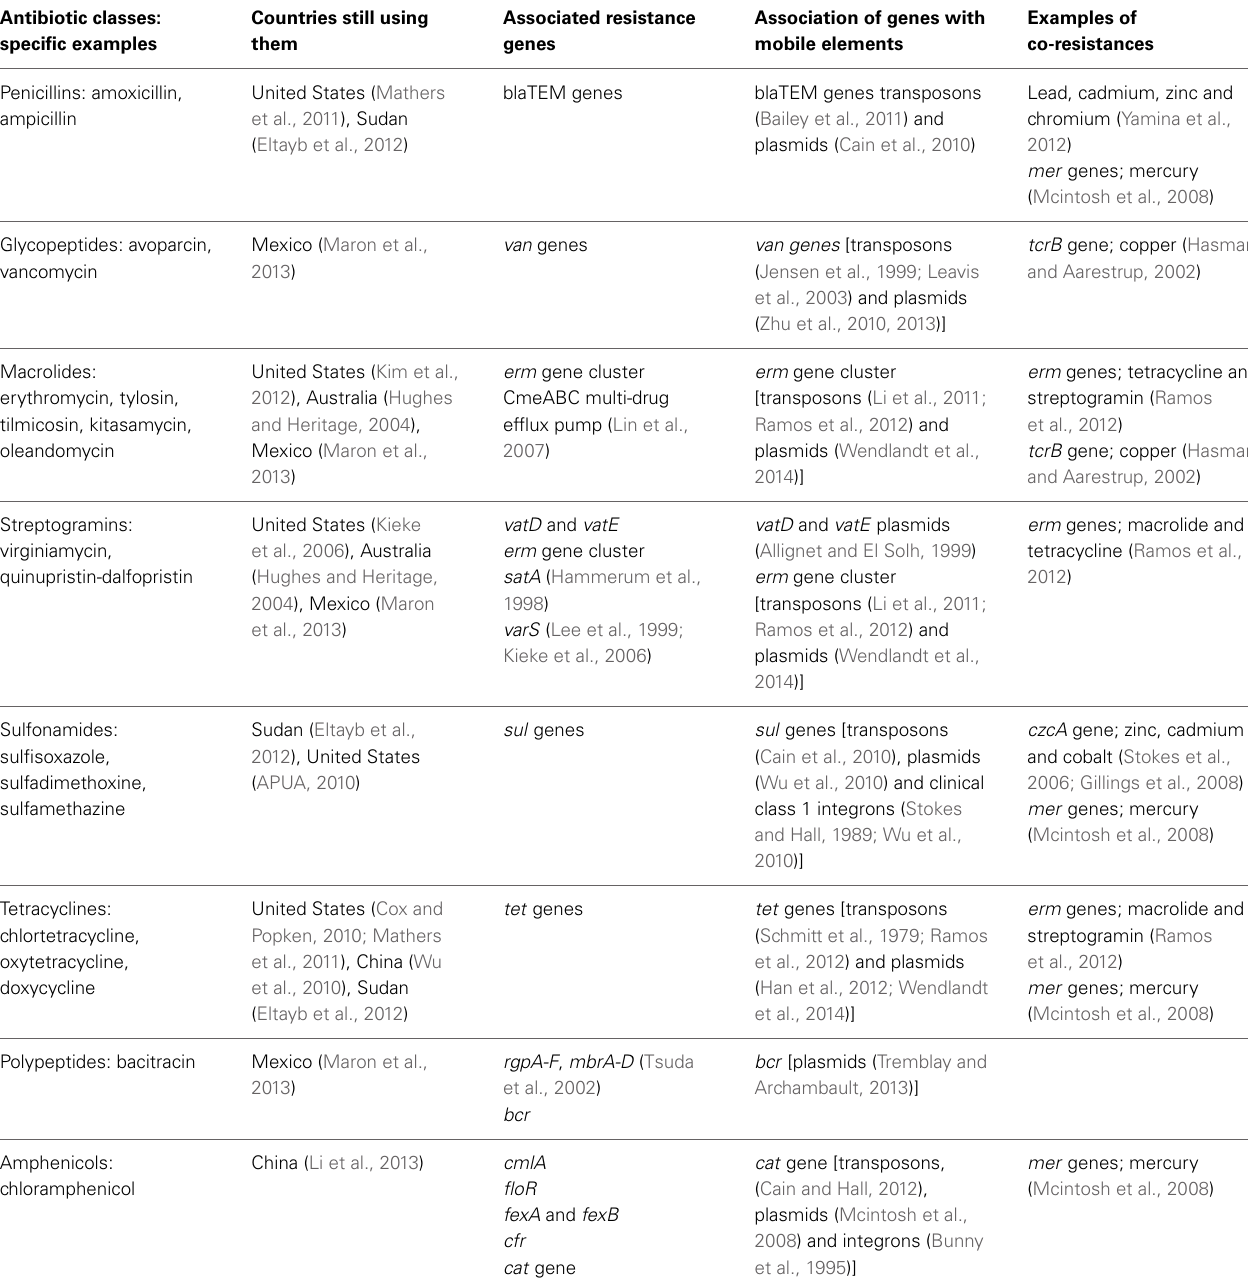
Table 1 | List of FDA approved Antibiotic classes and countries still using them in growth promotion, associated resistance genes and genetic scaffolds that laterally co-mobilize them with other antibiotic and metal resistance